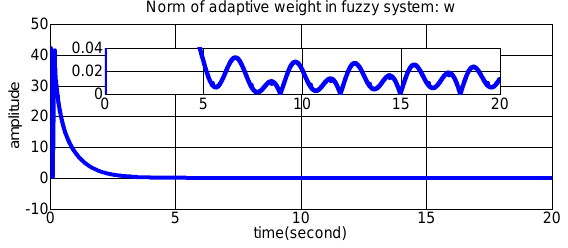
Figure 19. Norm of adaptive weights of fuzzy system.